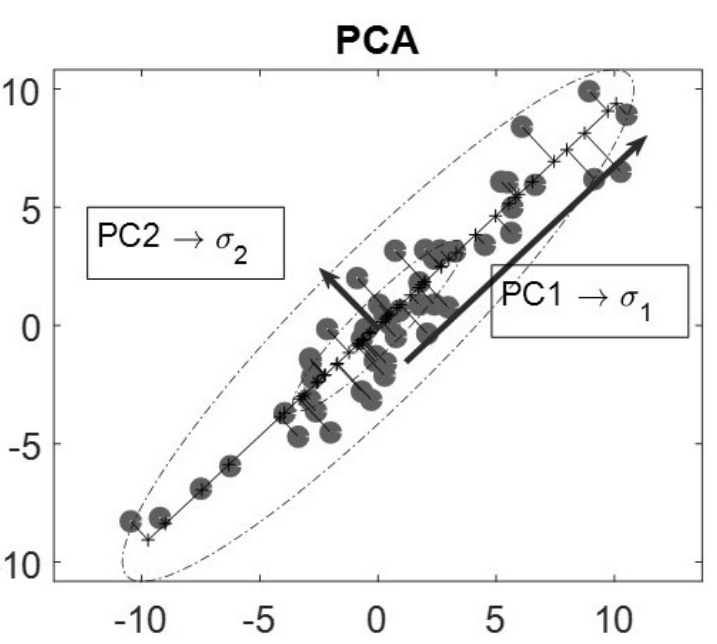
Figure 3. Example of PCA dimension reduction: the principal components PC1 and PC2 are ob- tained as the mutually orthogonal directions where the variance of the original data is maximized, respectively, labelled as σ 1 and σ 2 .